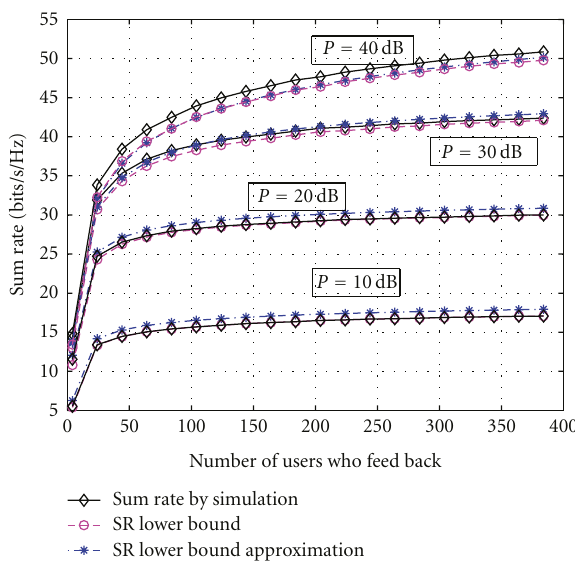
Figure 3: Sum Rate versus DL power P for various numbers of users feeding back.